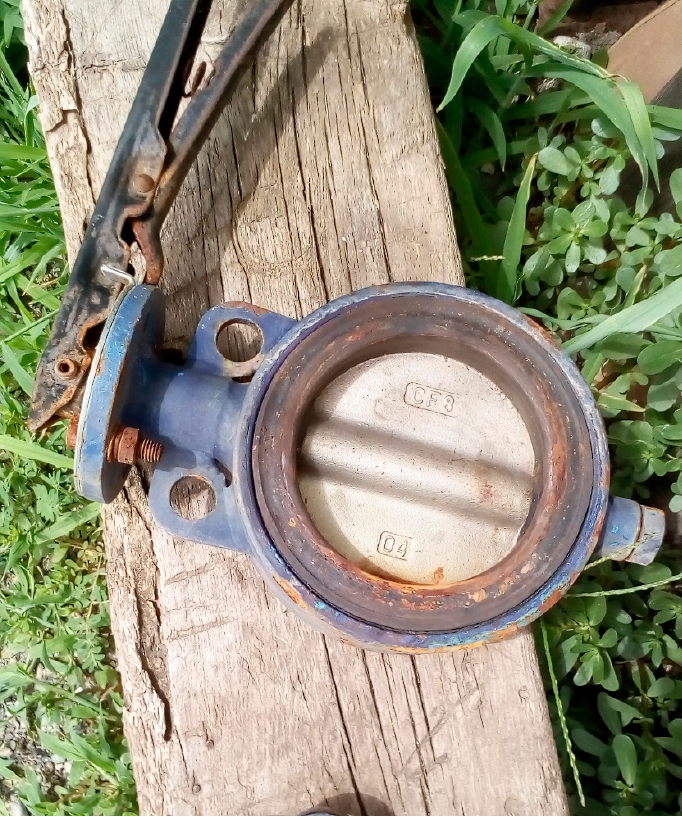
Figure 21. The appearance of the valve installed in the geothermal heating system with an acoustic–magnetic device.